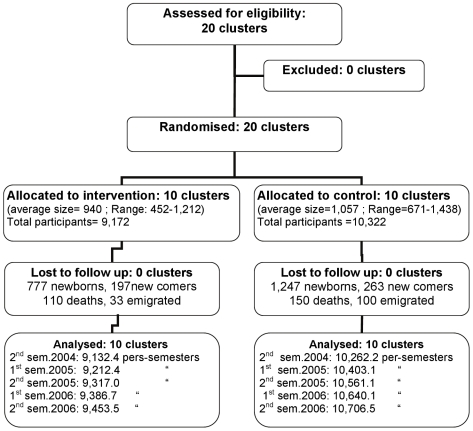
Flowchart of the study.